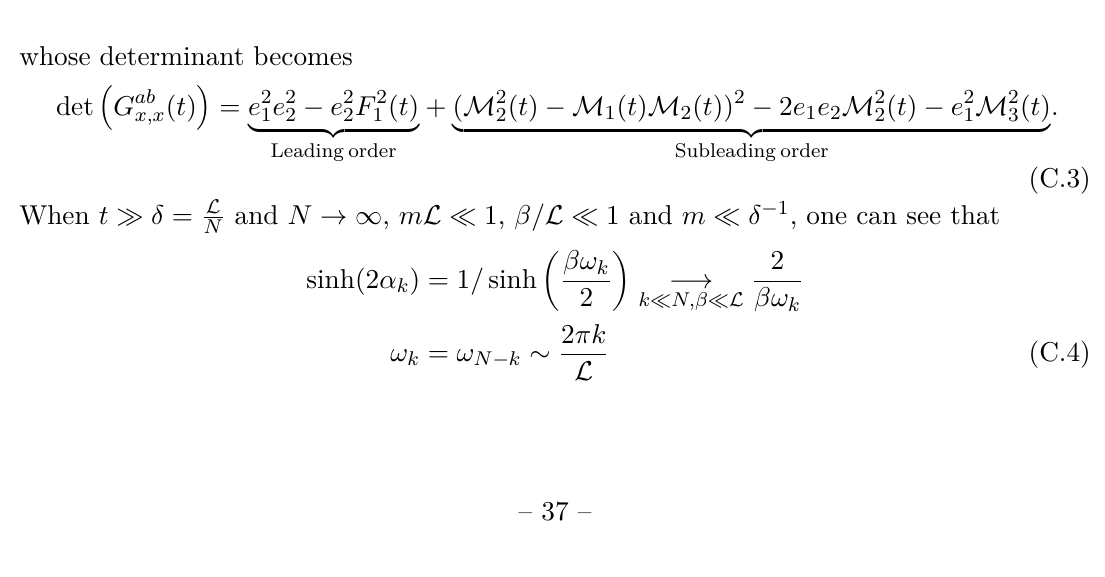
Figure 18 . Mass effect on long-time evolution of ∆ S = S OEE − S EE and E . These are normalized by the thermodynamic entropy S